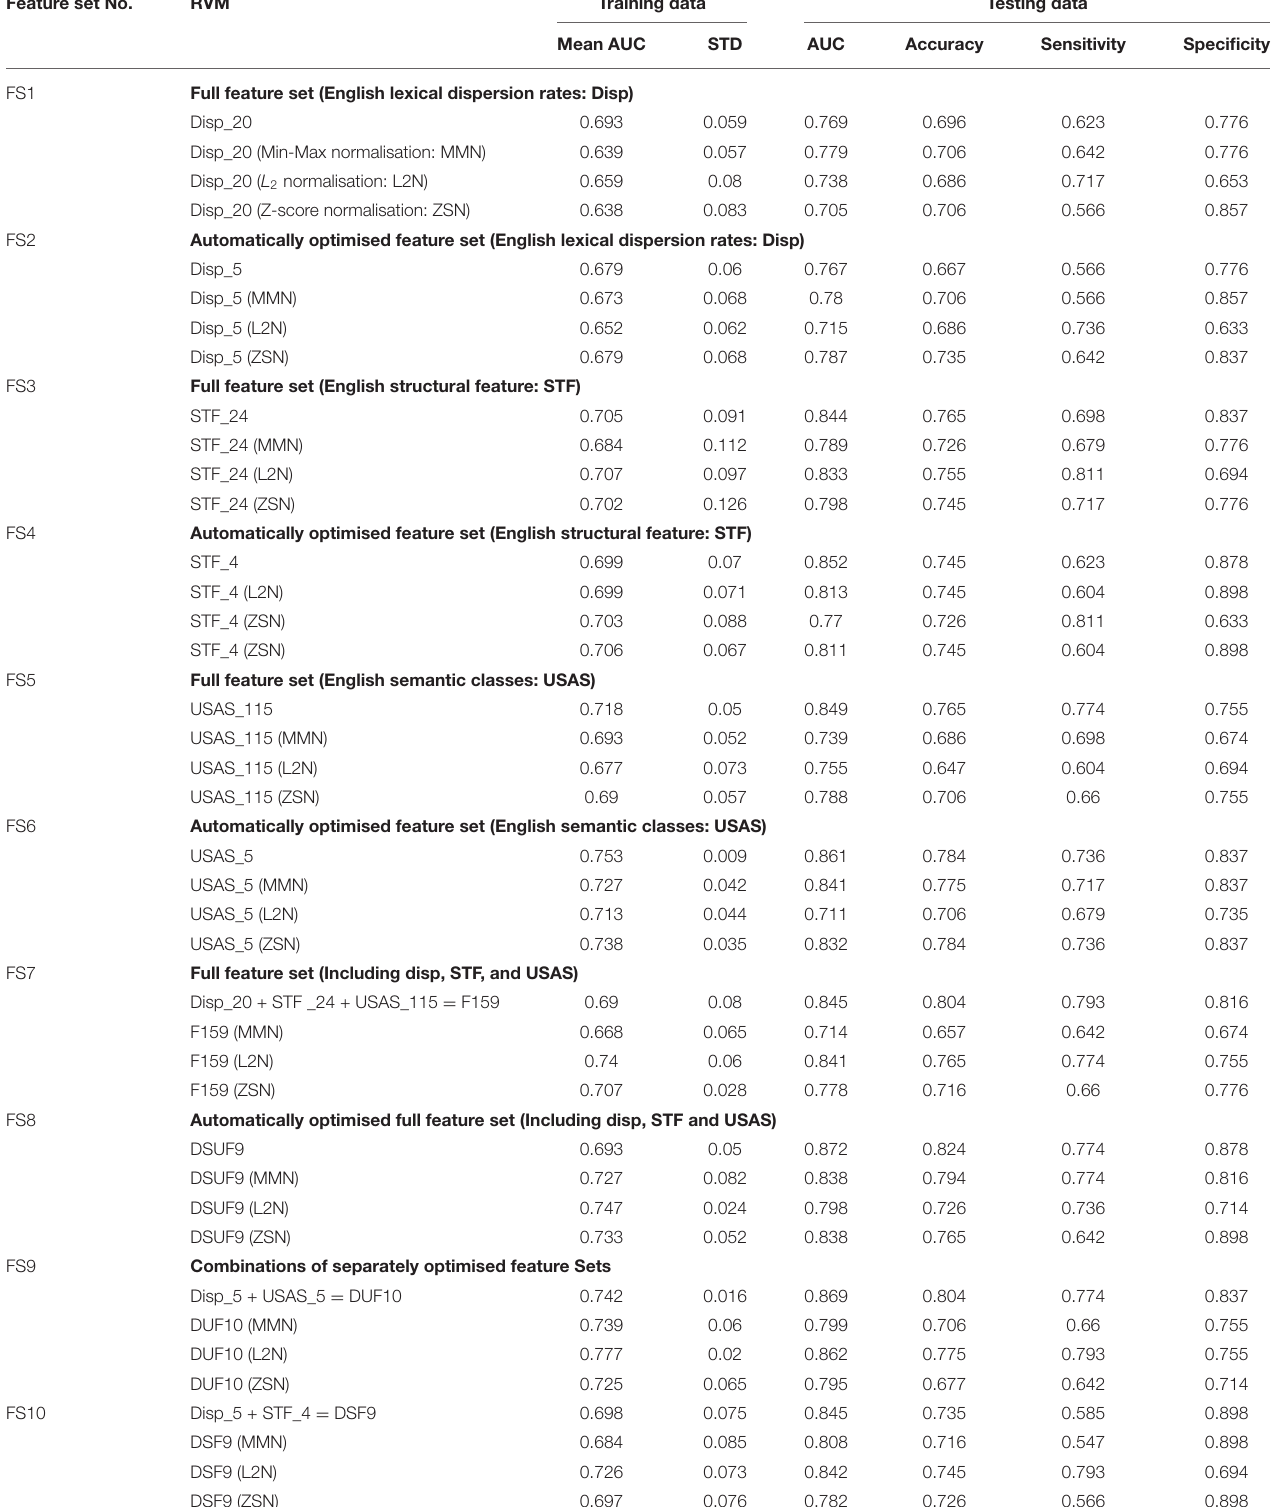
TABLE 5 | Data distribution of training and testing dataset. Feature set